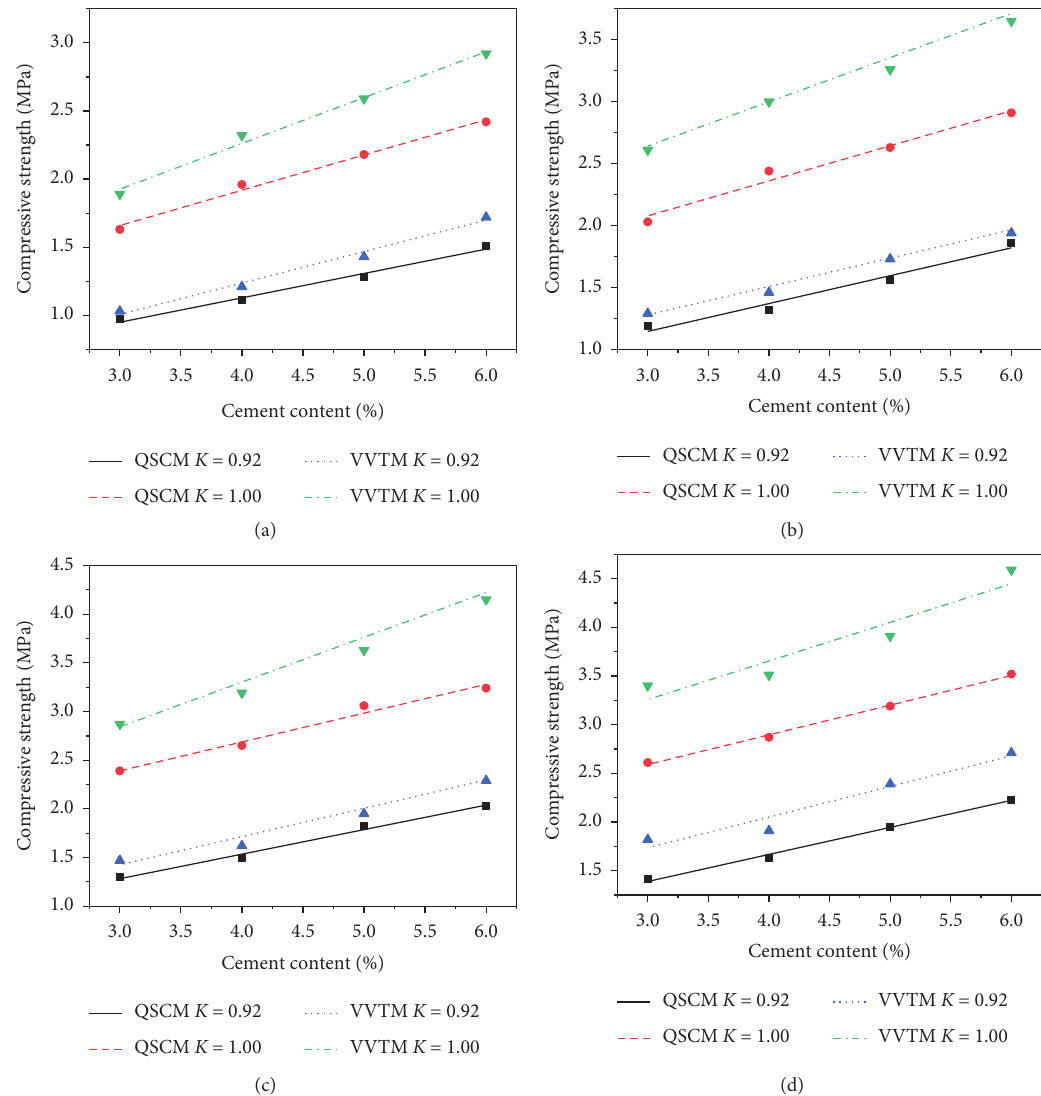
Figure 4: Influence of cement content on UCS of CSL compacted using VVCM and QSCM. (a) 7 d. (b) 14d. (c) 28d. (d)